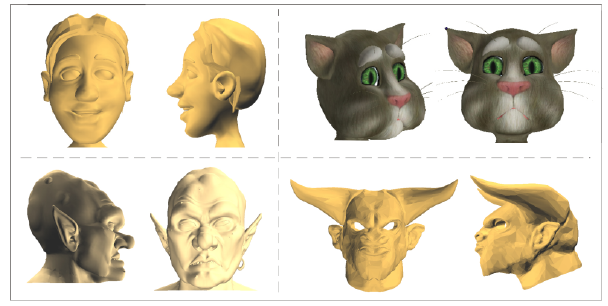
Figure 16. Models used in the case study.